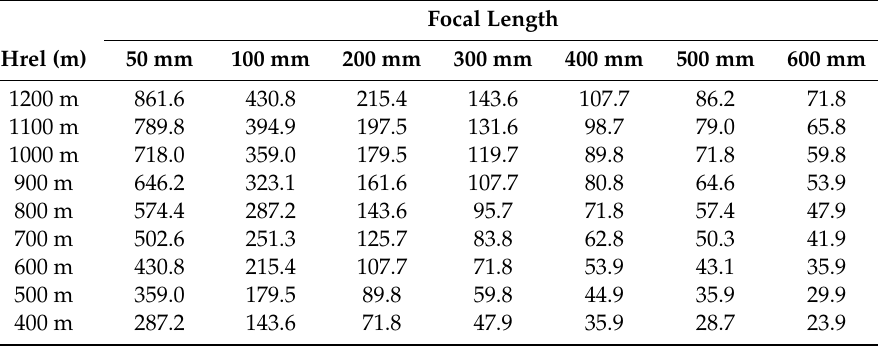
Table 3. Swath width (m) as a function of relative flight altitude and lens focal length. Hrel: altitude above